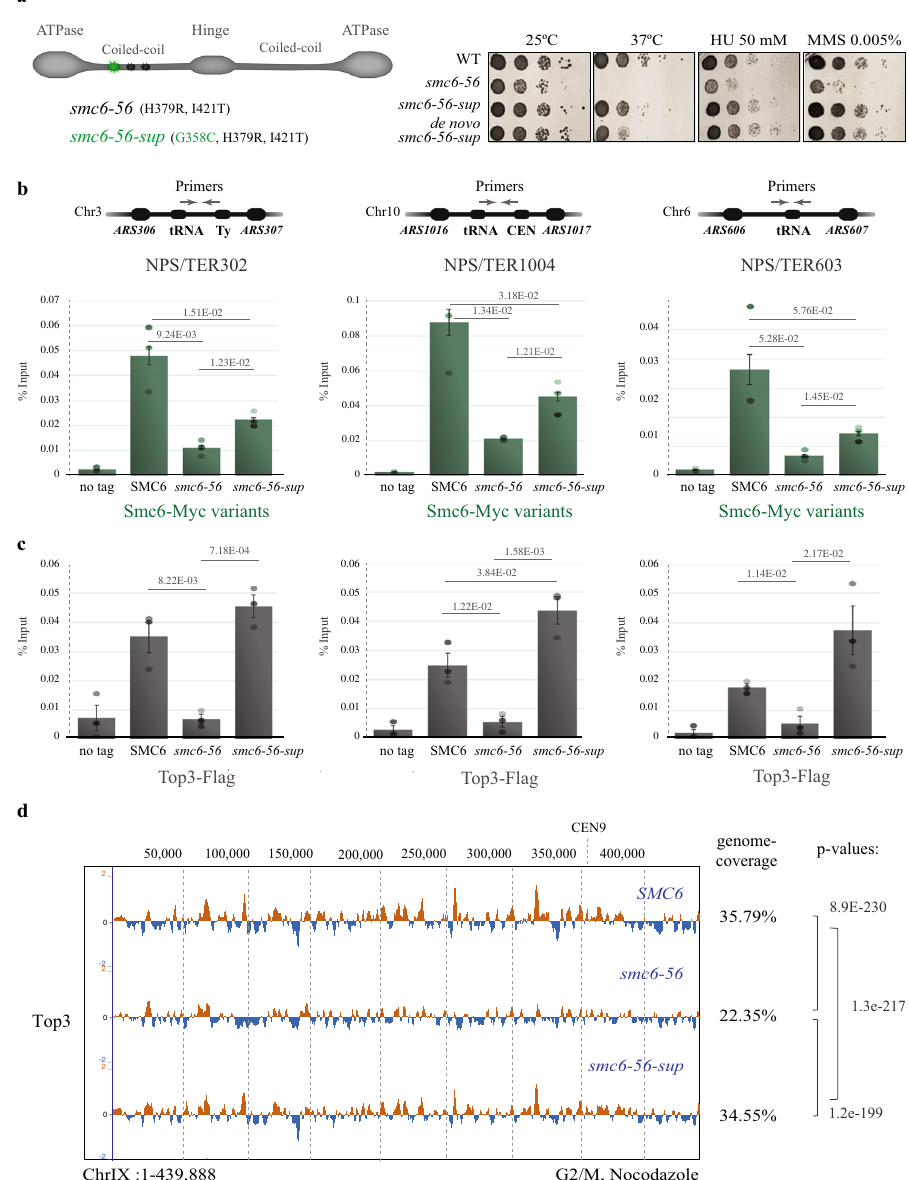
Fig. 4 Intra-allelic smc6 suppressor unveils tight links between Smc5/6 and Top3. a Schematic representation of the smc6-56 suppressor screen. Representation of the point mutations in smc6-56 -sup and validation of the suppressor by creating the suppressor mutation de novo in smc6-56 . b ChIP- qPCR analysis of Myc-tagged Smc6 and variants versus no tag in G2/M phase at three indicated NPSs. c ChIP-qPCR analysis of Top3-Flag in WT, smc6-56 and smc6-56-sup versus no tag in G2/M phase at three indicated NPSs. For ChIP-qPCR ( b and c ), the % Input is derived from three biological replicates and data are presented as mean value ± SEM. p -values were calculated by an unpaired two-tail t -test. d ChIP-on-chip pro fi le of Top3-Flag from G2/M- synchronized WT, smc6-56 and smc6-56-sup mutant cells performed in two biological replicates. Chr IX is shown as example. The indicated p -values (one- tailed Fisher ’ s exact test) relate to the genome-wide overlap between the considered protein clusters (see legend of Fig. 1a for details). Genome coverage percentage of Top3 is indicated. See also Supplementary Fig. 5. Source data are provided as a Source Data fi